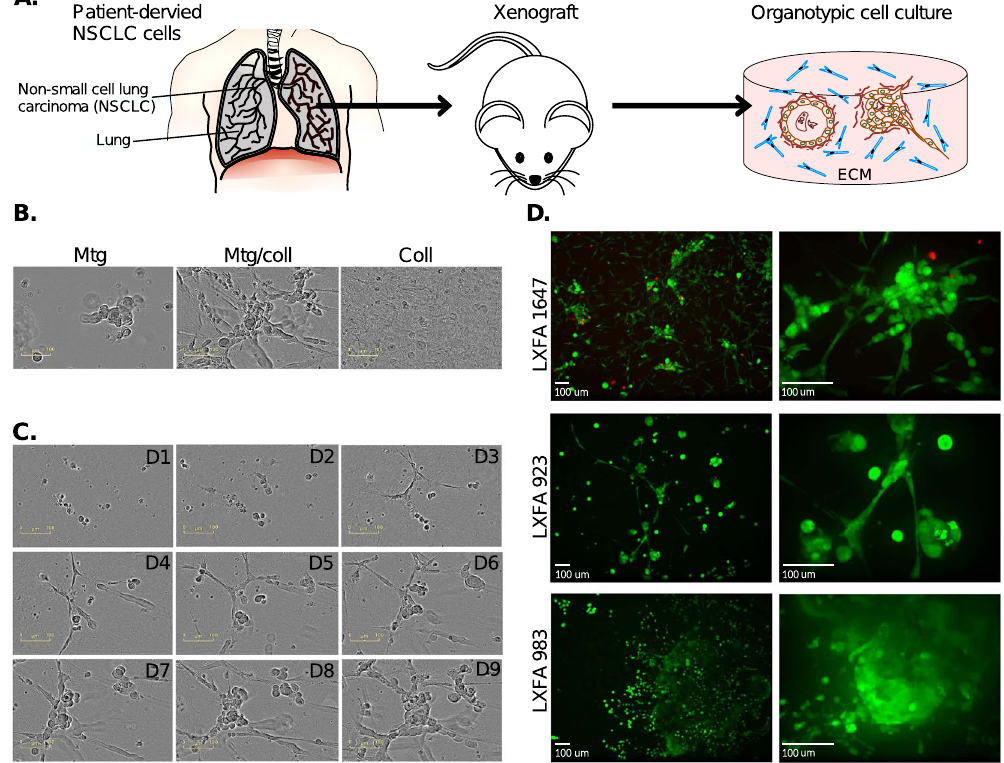
Figure 1. Patient-derived xenograft (PDX) microtissue models of non-small cell lung carcinoma (NSCLC). ( A ) Cells from NSCLC patients were isolated and propagated as mouse xenografts to maintain and enrich for the tumor material. Tumor and stromal cells were isolated as single cell suspensions, a fraction of which was directly cultured for 12 days as organotypic cultures embedded in extracellular matrix (ECM). ( B ) Optimization of extracellular matrix (ECM) preparations used for 3D culture, using Matrigel, type I collagen, and a 1:1 mixture of both. ( C ) Spontaneous PDX microtissue generation (LXFA 1647) from single cells, for 9 days of culture in ECM (Matrigel-collagen). ( D ) Live-cell staining for living cells with Calcein AM (green). Confocal imaging of representative PDX microtissues shows characteristic morphologies formed by PDX tumors LXFA 923, LXFA 983, and LXFA 1647. A blow up image is shown on the right. Scale bars: 100 μ m . The first two images in A are distributed on pixabay . com under CC0 Public Domain